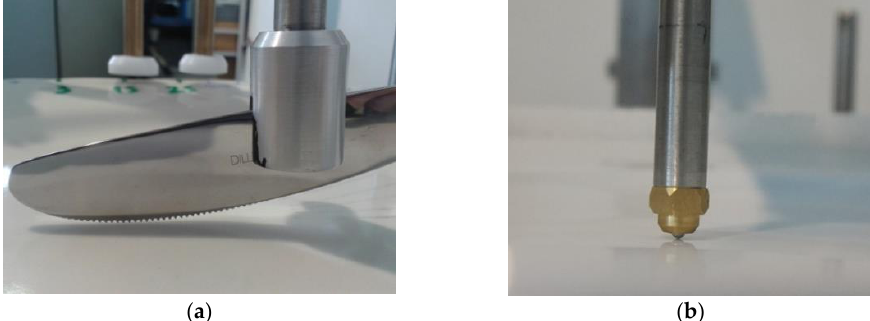
Figure 12. Detail on metal marking test ( a ) knife and ( b ) ø 2.5 mm stainless steel ball fixed on adapter.